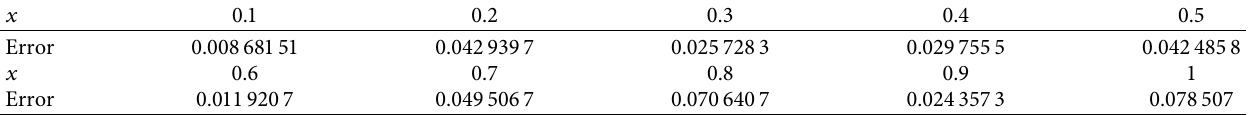
Table 2: The error of solution r ( t )( t ∈ [ 0 , 1 ]) of Example